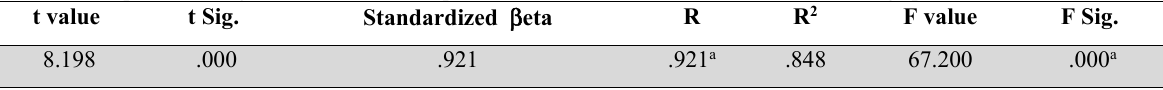
Results of simple linear regression to test the impact of board of directors’ size effect on earnings per share (EPS) indicator value t